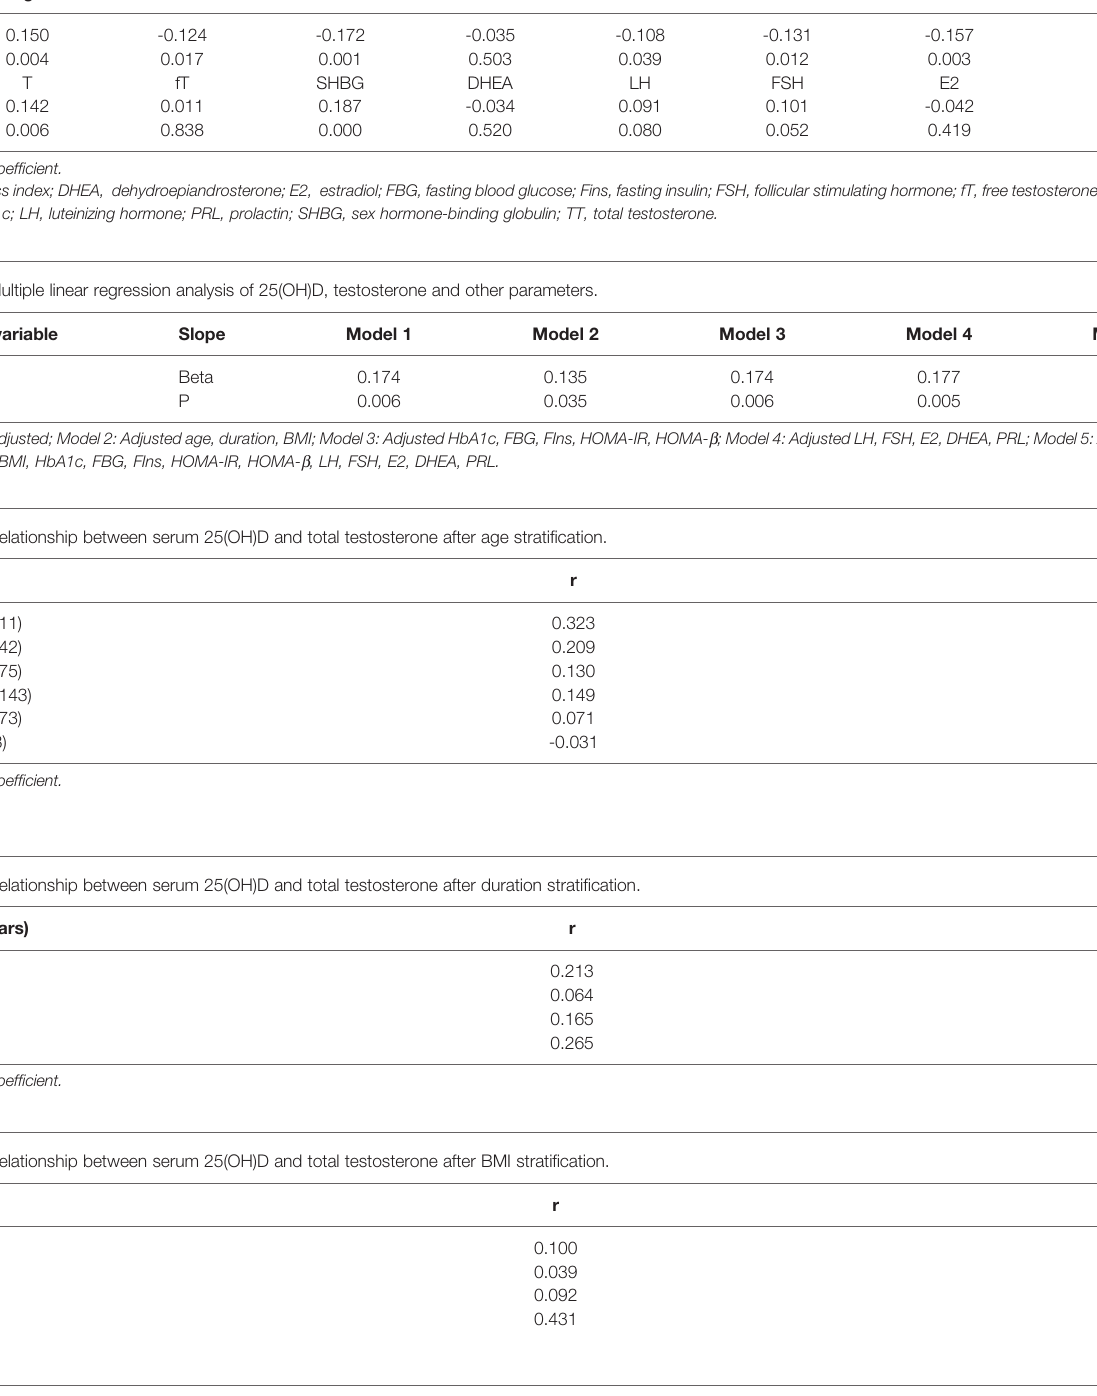
TABLE 8 | Relationship between serum 25(OH)D and total testosterone after HbA1c strati fi cation. HbA1c (%) r P